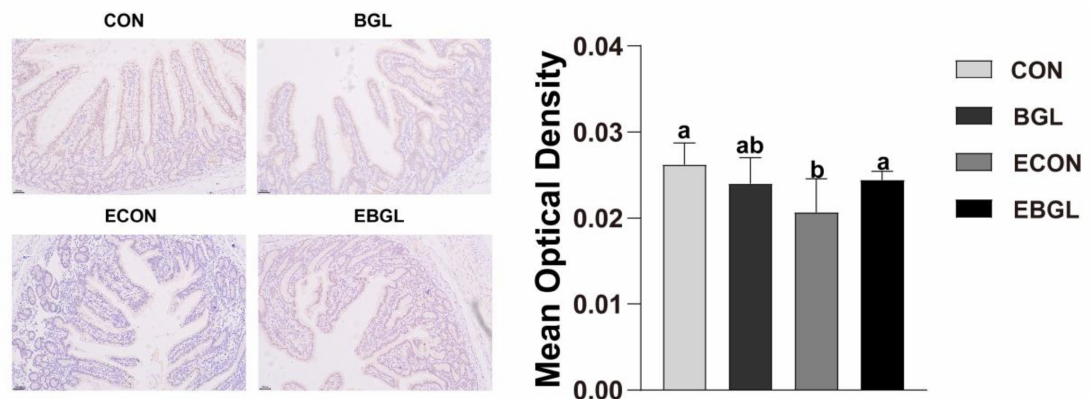
Figure 4. Effects of BGL on the sIgA content in the jejunum of weaned pigs upon ETEC challenge. (immunohistochemistry: × 100). Secretory immunoglobulin A, sIgA. a, b, values within a row with different superscript letters are significantly different ( p < 0.05). CON, pigs were fed with a basal diet; BGL, pigs were fed with a BGL-containing diet (500 mg/kg); ECON, pigs were fed with a basal diet and challenged by ETEC; EBGL, pigs were fed with a BGL-containing diet and challenged by ETEC.